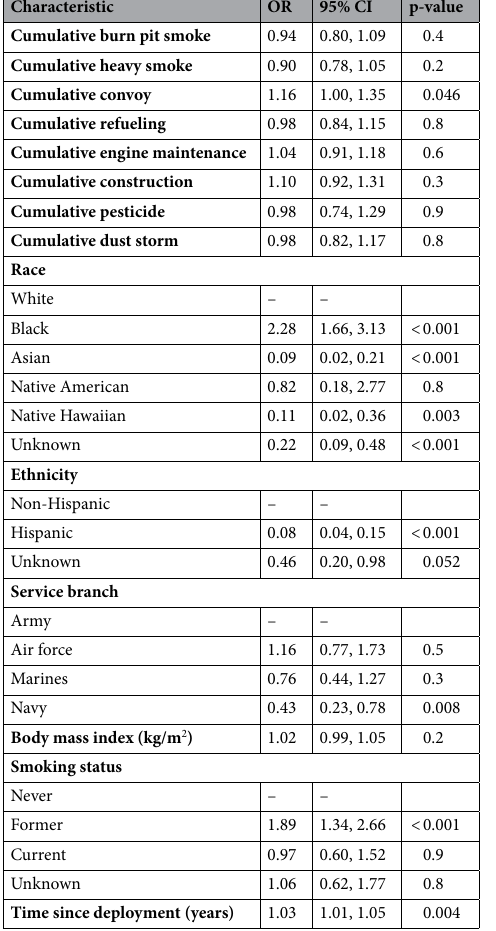
Table 3. Multivariable logistic regression model reporting odds of association between sarcoidosis and cumulative deployment related exposures (in 6-month increments) and participant characteristics among 661 cases and 2641 age- and sex-matched participants from the Airborne Hazards and Open Burn Pit Registry cohort who used the Veterans Health Administration. OR odds ratio, CI confidence